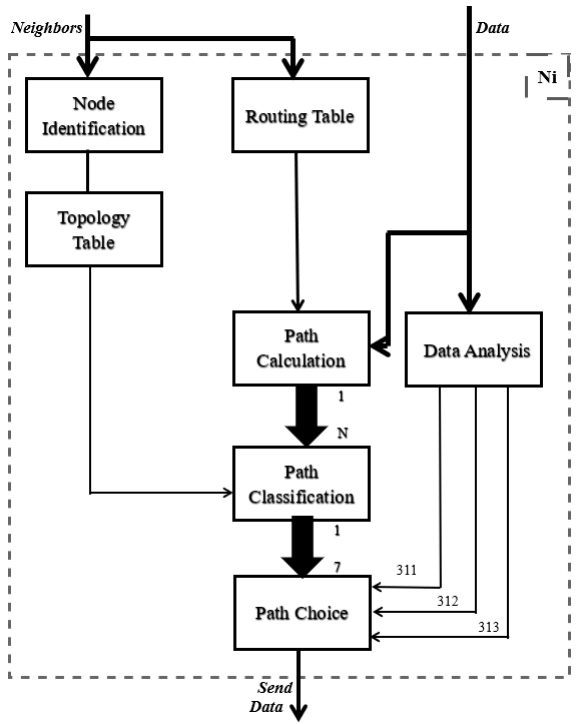
Figure 1. Node communication architecture [14].